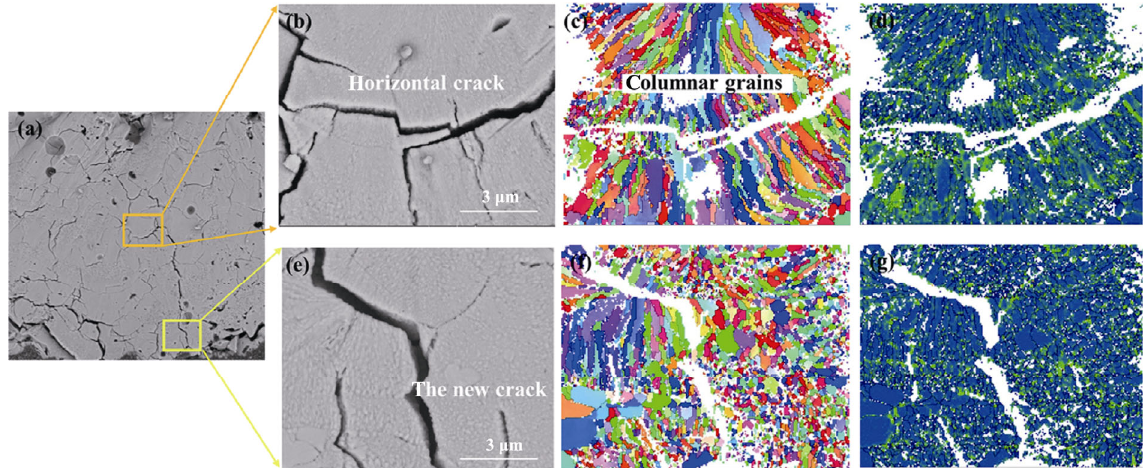
Fig. 6 (a) SEM image of Al 2 O 3 –YSZ coating; two areas selected near the crack: (b) site 1 and (e) site 2; (c, f) EBSD images and (d, g) local misorientation distribution images of sites 1 and 2,